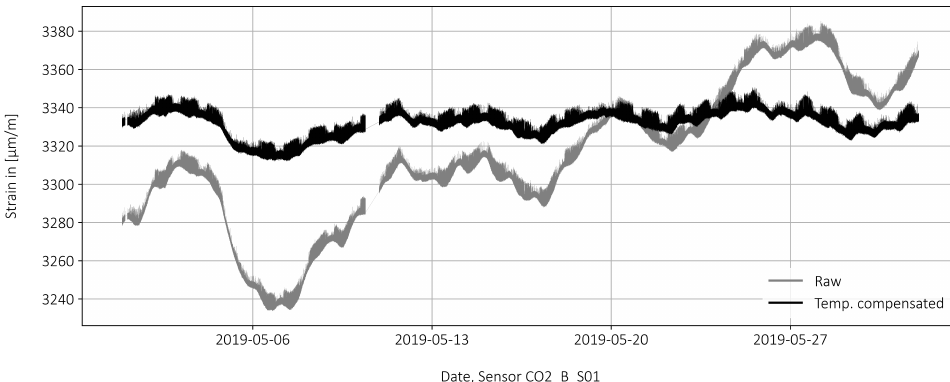
Figure 6. Raw strains from Figure 4 after temperature